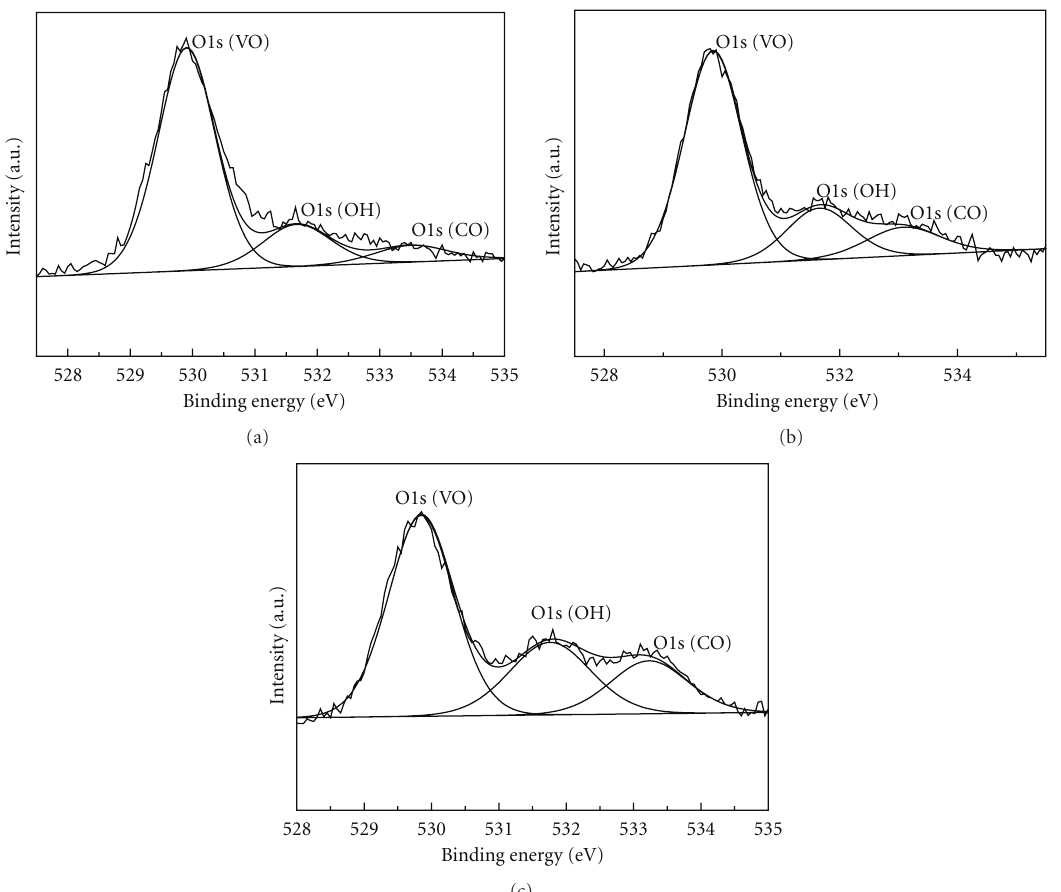
Figure 6: XPS spectra of BiVO 4 (s-m) under di ff erent pH. (a) pH = 3.0, (b) pH = 5.0, (c) pH =